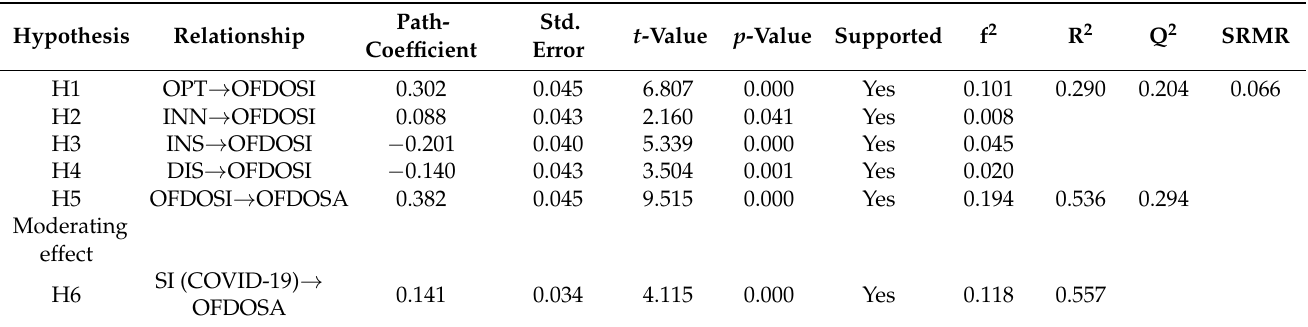
Table 4. Hypotheses